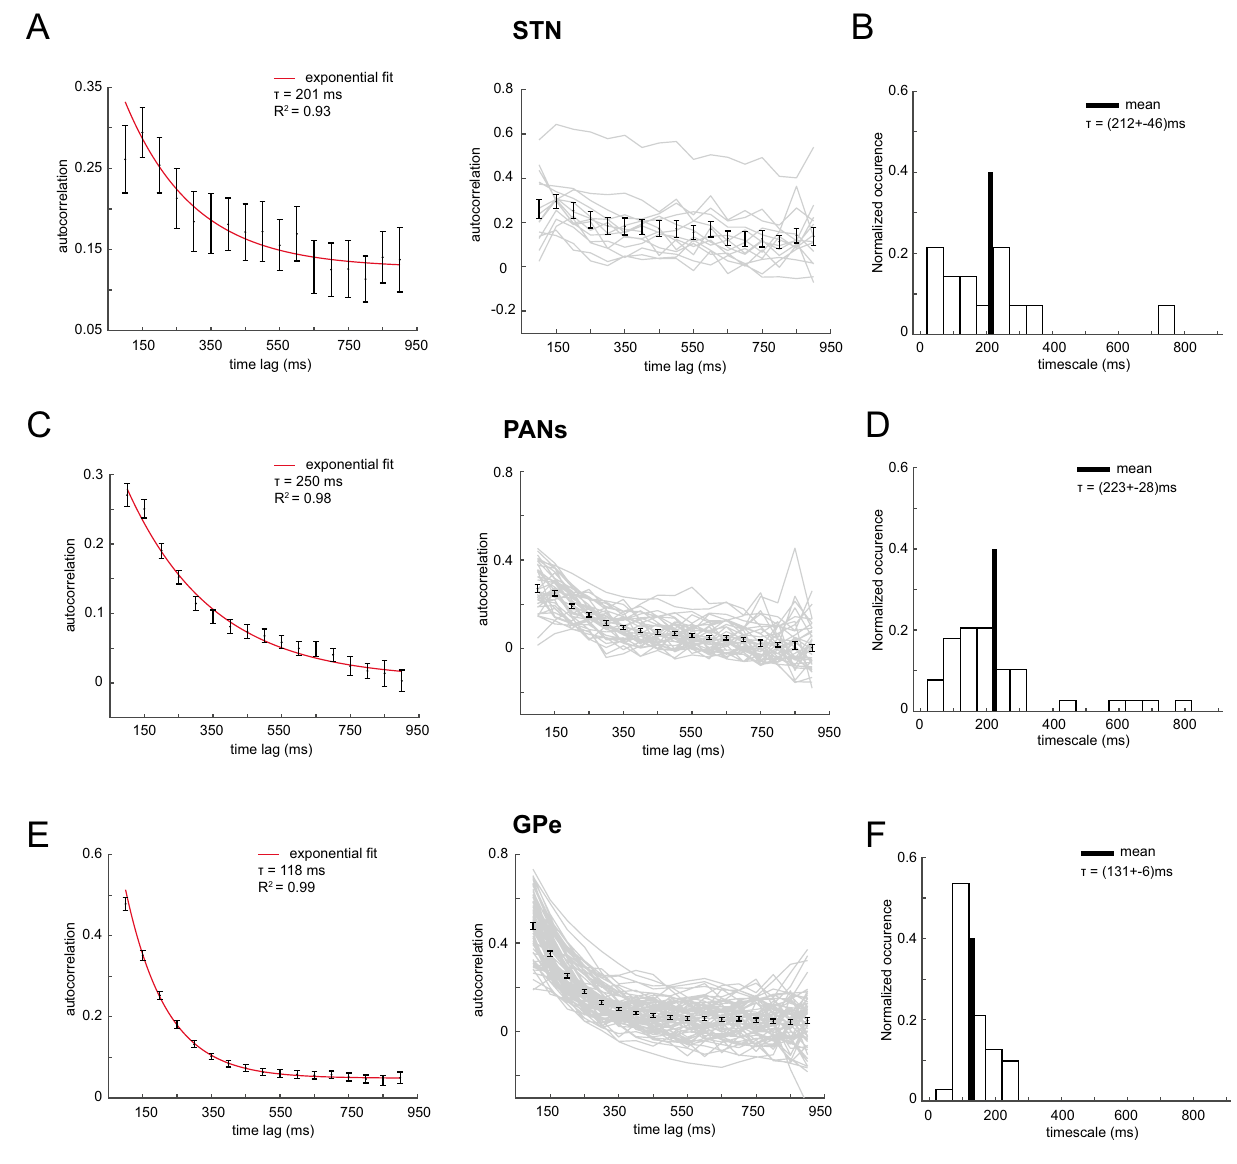
Figure 1. Mean autocorrelation values and single timescale distribution. ( A ) Left Panel: mean autocorrelation averaged across all neurons (n = 14) recorded in the subthalamic nucleus (STN) using 50 ms time bins in a 900 ms time window during the baseline period (mean ± SEM). The solid red line is the exponential fit. The autocorrelation at 50 ms has been excluded from the fit procedure. The intrinsic timescale τ is shown in the top right corner, with the R 2 value as a goodness of fit estimator. Right panel: single neuron autocorrelation structure (grey lines) with the mean and standard error bar for each time lag (black bars). ( B ) Single neuron timescale distribution for STN (n = 14) computed in the same baseline period as in the population timescale shown on the left panel. The solid line is the mean. The mean of the timescale distribution is shown in the top right corner with the standard error of the mean. The median of the distribution is 178 ms, while the mode gets two values, 50 ms and 200 ms. ( C ) Left Panel: mean autocorrelation averaged across neurons (n = 39) recorded in phasically active neurons (PANs) of the striatum in the same baseline period as ( A ). The autocorrelation value at 50 ms has been excluded from the fit procedure as in A). Right panel: same as in ( A ) right panel. ( D ) Single neuron timescale distribution for PANs (n = 39). The median of the distribution is 181 ms, while the mode gets two values, 50 ms and 150 ms. ( E ) Left Panel: mean autocorrelation averaged across neurons (n = 71) recorded in the external globus pallidus (GPe) in the same baseline period as ( A ) and ( C ). The autocorrelation values at all time lags have been included in the fit procedure. Right panel: same as in ( A ). ( F ) Single neuron timescale distribution for GPe neurons (n = 71). The median and mode of the distribution are 115 ms, and 100 ms,